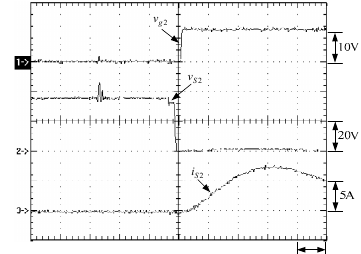
Figure 32. Waveforms pertaining to S a at the rated load: (1) v ga ; (2) v Sa ; and (3) i Sa .